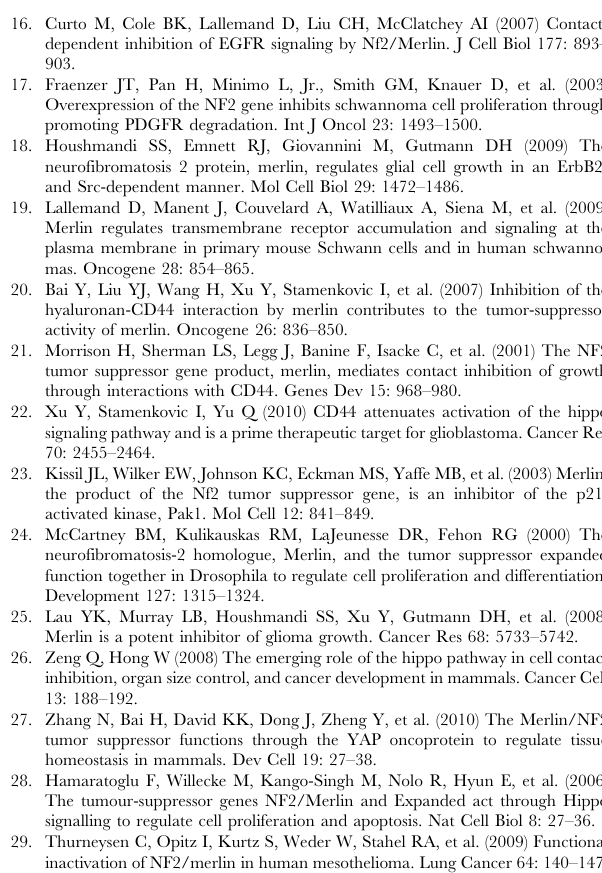
Figure S3 Endogenous merlin expression is diminished in a subset of human melanoma cell lines. Western blot analysis of endogenous merlin expression was performed using the indicated human melanoma cell lysates and anti-merlin antibody (Santa Cruz). Arrows indicate metastatic melanoma cell lines with little or significantly reduced merlin expression. 50 m g of protein was loaded in each lane and actin was used as a loading control.